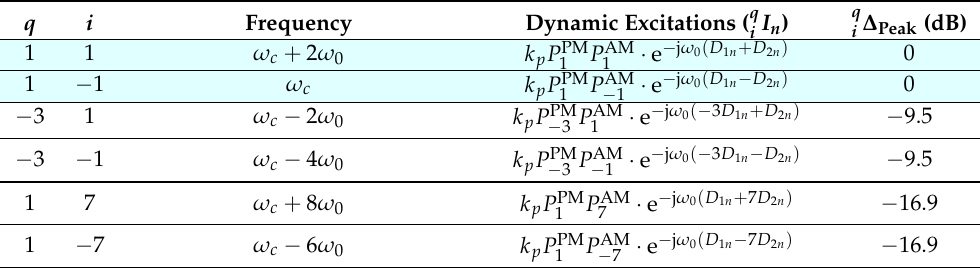
Table 1. Characteristics of the dominant harmonic patterns of Equation (6) in decreasing order of significance. Both AM and PM modulating waveforms are 4-level. The useful harmonics are shaded in light blue.